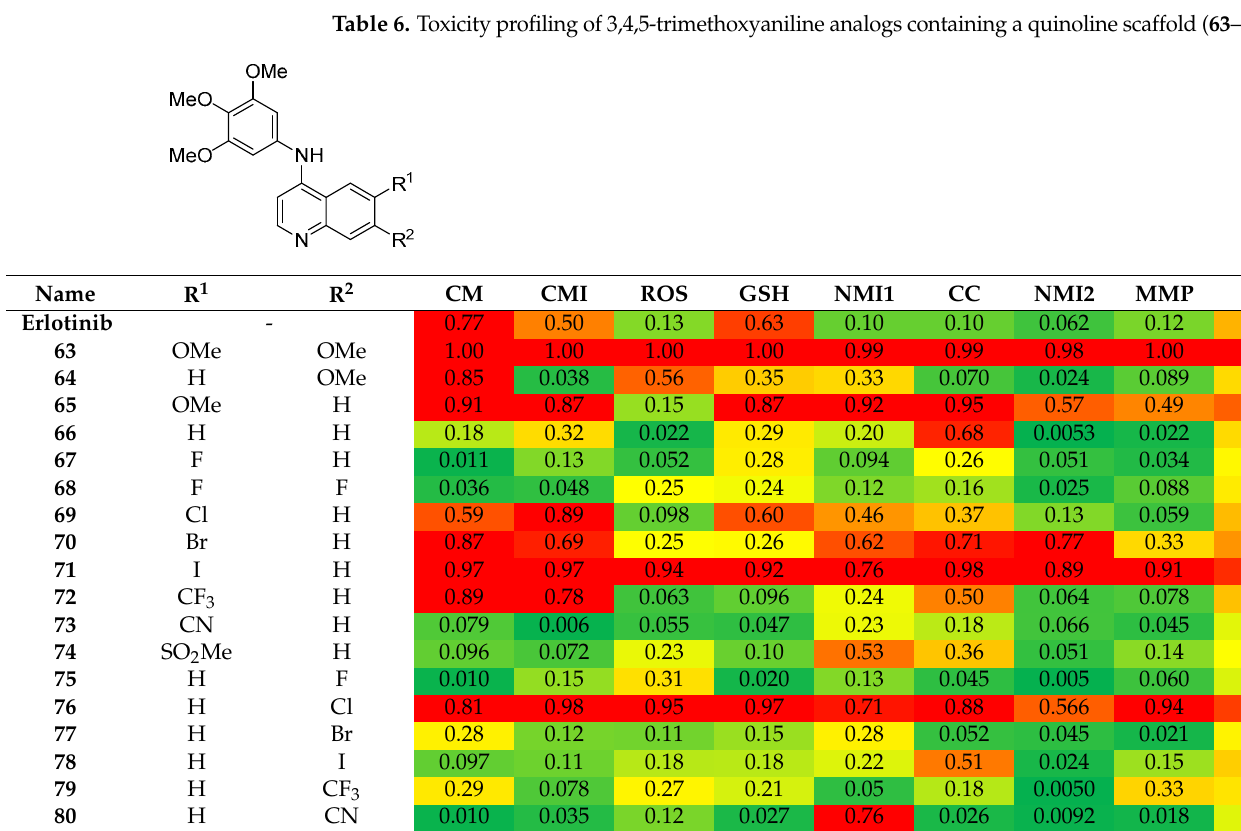
Table 6. Toxicity profiling of 3,4,5-trimethoxyaniline analogs containing a quinoline scaffold ( 63 – 80 ) a,b,c .